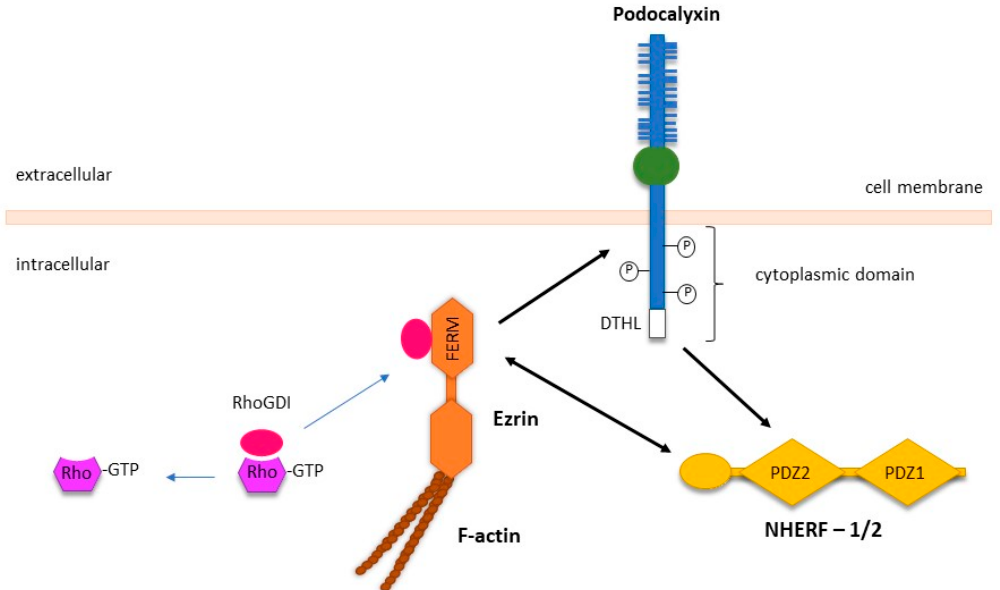
Figure 2. Interactions between PODXL and its intracellular binding partners' ezrin and NHERF1/2. The intracellular domain of PODXL contains several phosphorylation sites and a C-terminal DTHL motif, which can directly interact with the N-terminal FERM domain of ezrin. In addition, ezrin can interact with PODXL indirectly via the C-terminal of NHERF1/2, following the binding of the DTHL motif of PODXL to PDZ2 domain of NHERF1/2. Activation of the PODXL- NHERF-1/2-ezrin complex results in subsequent binding to the actin cytoskeleton. Sequestration of RhoGDI by ezrin releases Rho-GDP, which converts to Rho-GTP to enhance the activation of Rho-family GTPases. Specific protein-protein interactions are indicated by the black arrows. Adapted from McNagny and Hughes